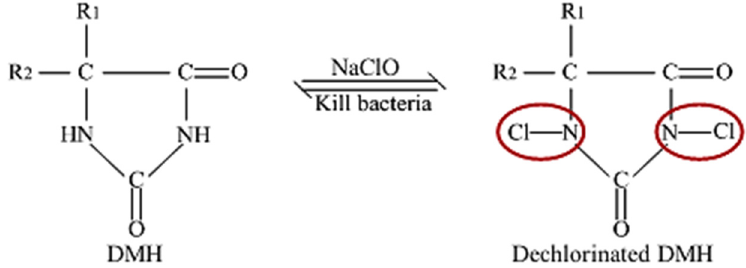
Figure 1. Reversible redox reaction of DMH (red circles show the N ‐ halamine structure) [25].